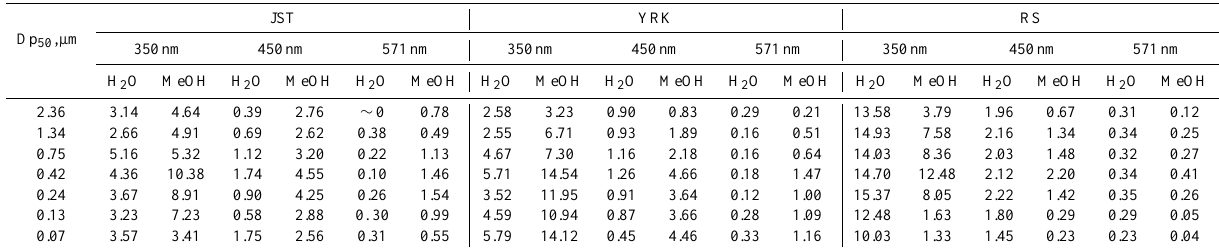
) , methanol-soluble 2 O